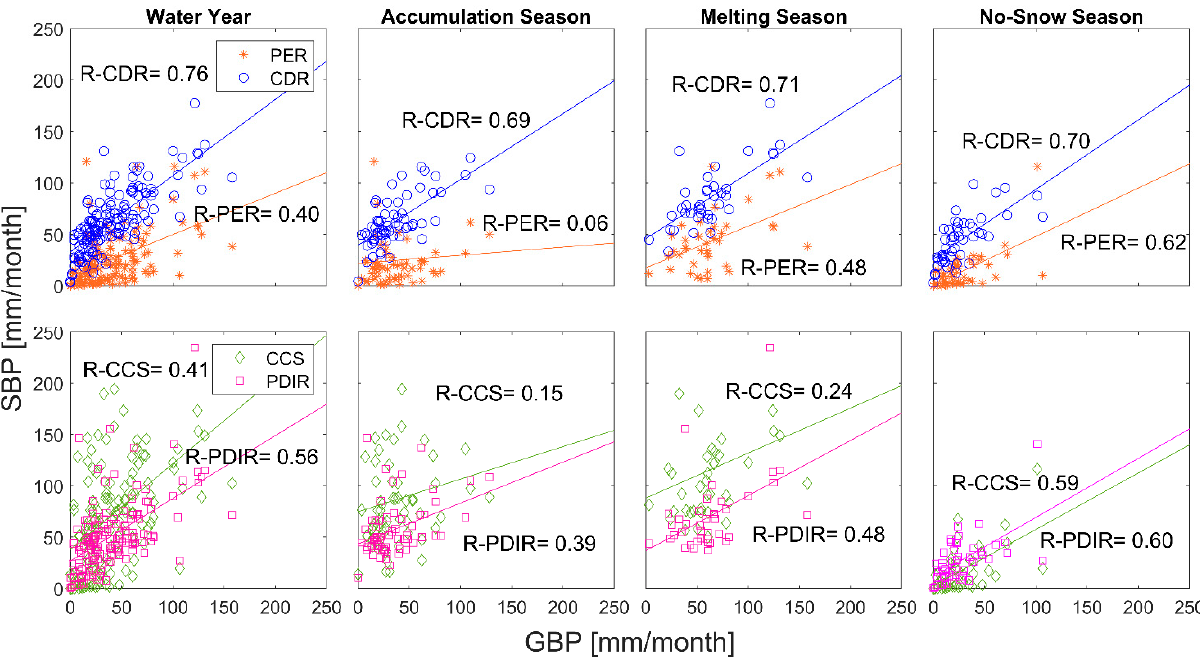
Figure 7. Monthly PVE of SBP data set with regression analysis (where p < 0.005 except for PER ( p = 0.6526), CCS ( p = 0.2377) during the accumulation season, and for CCS ( p = 0.1403) during the melting season). * GBP: Gauge-based Precipitation, PER: PERSIANN, CDR: PERSIANN-CDR, CCS: PERSIANN-CCS, PDIR: PERSIANN-PDIR-Now.